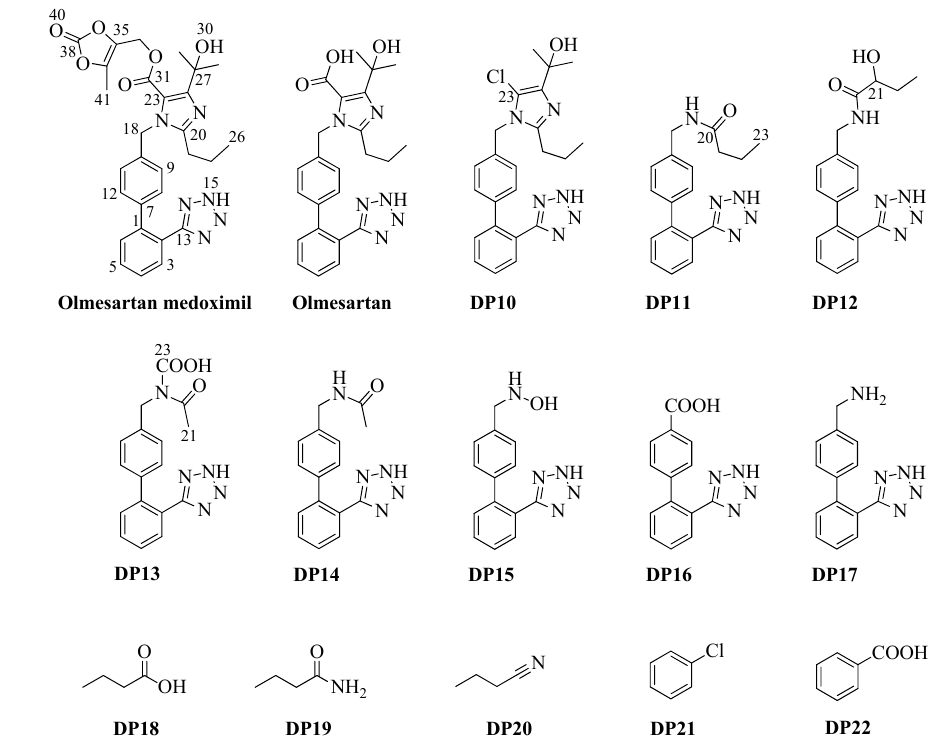
Figure 2. Chemical structures of olmesartan acid and its degradation byproducts DP10–DP22.